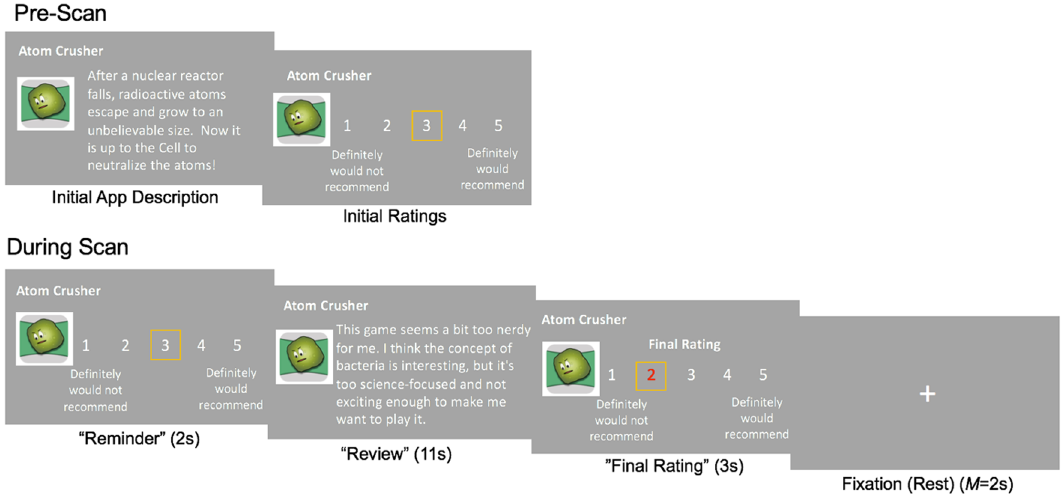
Figure 1. Task Schema. Before the scan, participants saw descriptions of 80 mobile game apps and provided initial ratings of their likelihood to recommend each app to others. In the scanner, participants were first reminded of their initial recommendation ratings. Then, they read peer recommendations about each of the 80 mobile game apps. Recommendations ranged in valence, with some being positive and others negative. During the final rating period of the scan, participants had the opportunity to update their recommendation ratings based on the peer